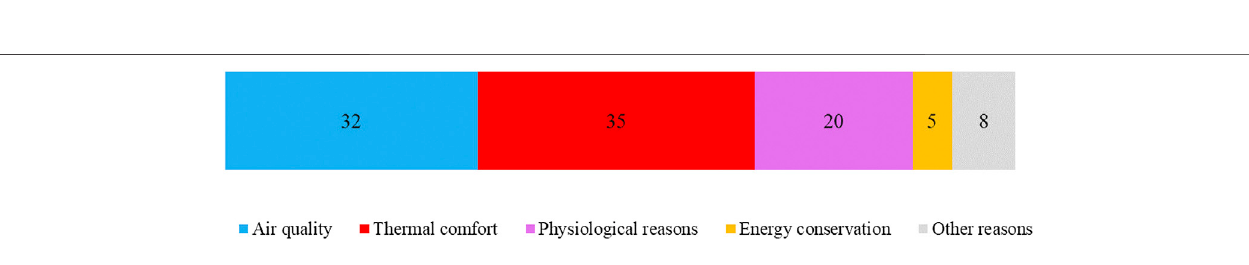
FIGURE 6 | Window usage at different a) outdoor PM levels and b) outdoor air temperatures. The “ low, ” “ medium, ” and “ heavy ” PM2.5 levels are < 25 μ g/m 3 , 25 – 100 μ g/m 3 , and > 100 μ g/m 3 , respectively. The “ cold, ” “ neutral, ” and “ hot ” outdoor air temperatures are < 10 ° C, 10 – 26 ° C, and > 26 ° C.